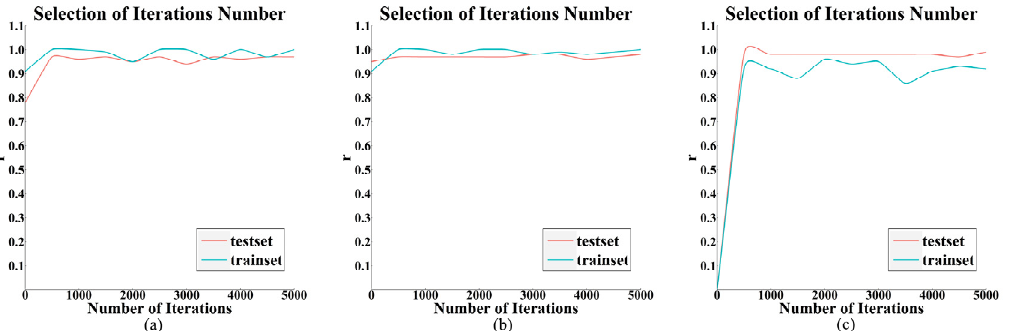
Figure 5. The change in R 2 based on XGBR model as the number iterations increases. ( a ) gamma = 0.001, eta = 0.6; ( b ) gamma = 0.001, eta = 0.3.; ( c ) gamma = 0.1, eta = 0.3.